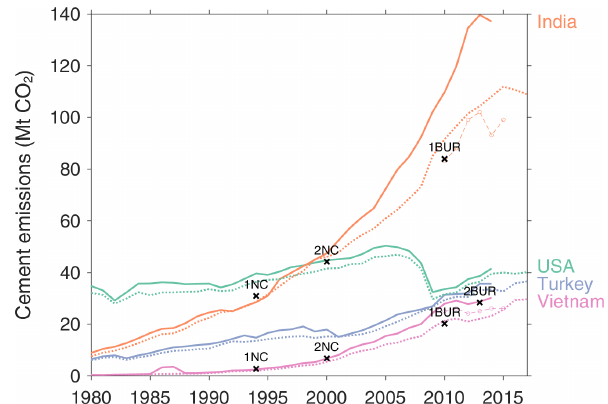
Figure 4. Comparing new cement emissions estimates (dashed lines) for the top four cement producers after China with those from CDIAC (solid lines), and official estimates (crosses, India and Viet- nam) as reported to the UNFCCC (see text). The new estimates for the USA and Turkey come directly from national official estimates. Estimates from EDGAR v4.3.2_FT2015 are shown for India and Vietnam with round